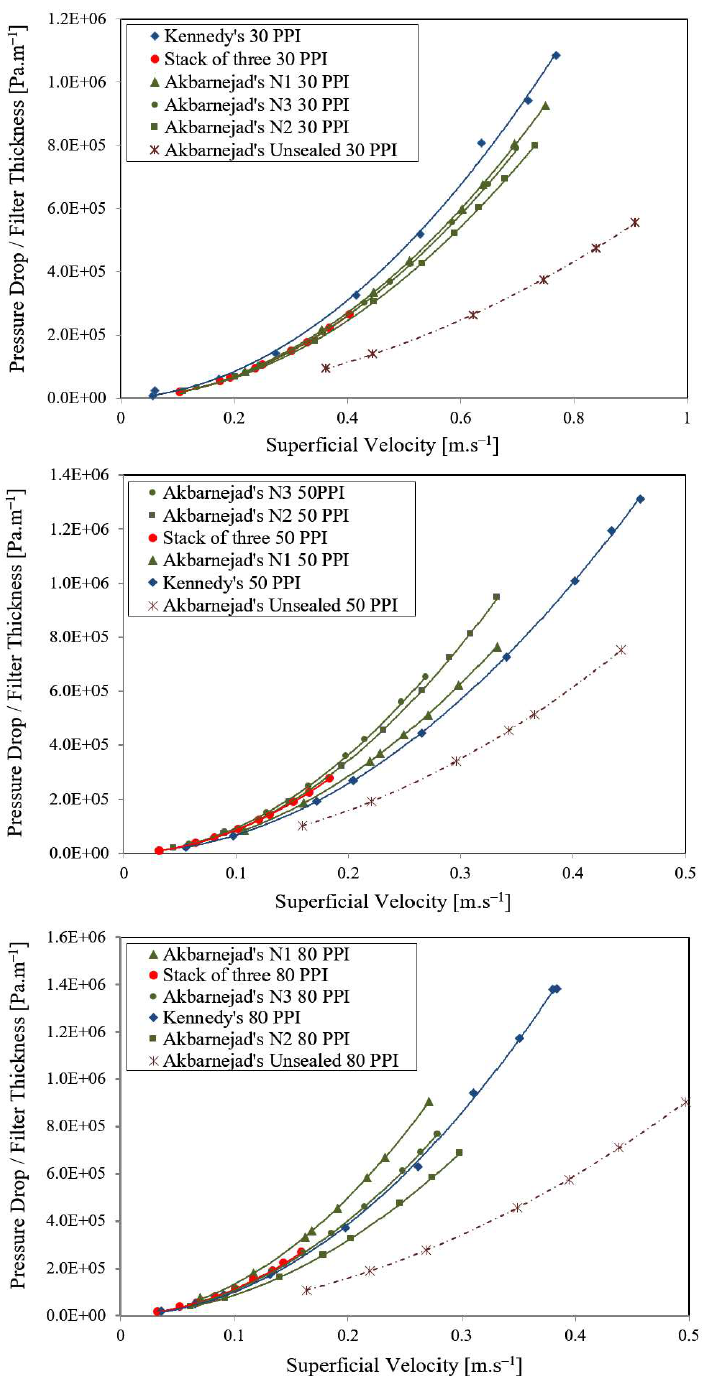
Figure 9. Experimentally obtained pressure gradients of stacks of three filters (the red, solid curves) vs. the experimentally obtained pressure gradients of single filters from previous studies by Akbarnejad et al., 2016 & 2017 [2,26,29] (the green, solid curves, as well as the pressure gradients of the unsealed single filters, the dotted curves) and Kennedy et al., 2013 [19] (the blue, solid curve) as a function of superficial velocity.